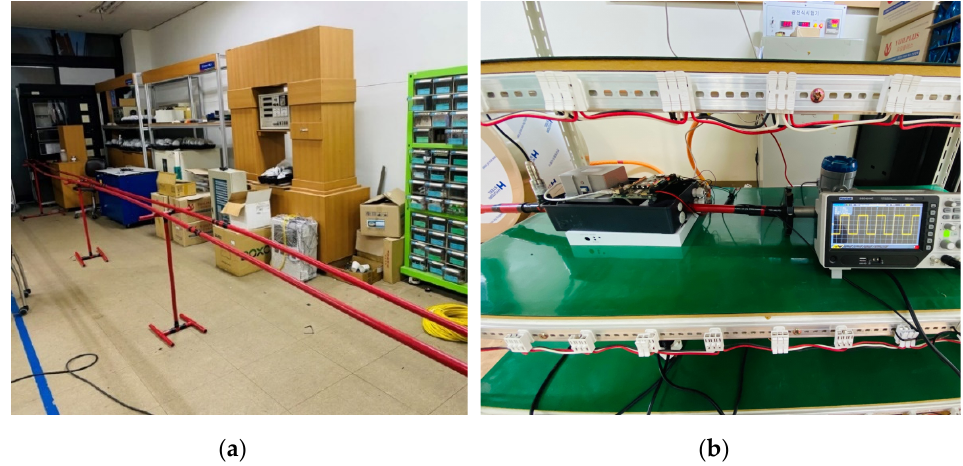
Figure A2. The aspirating smoke detection ( a ) The pipe hole network; ( b ) The pressure sensor, ASD 1, Flow Meter, and Oscilloscope.